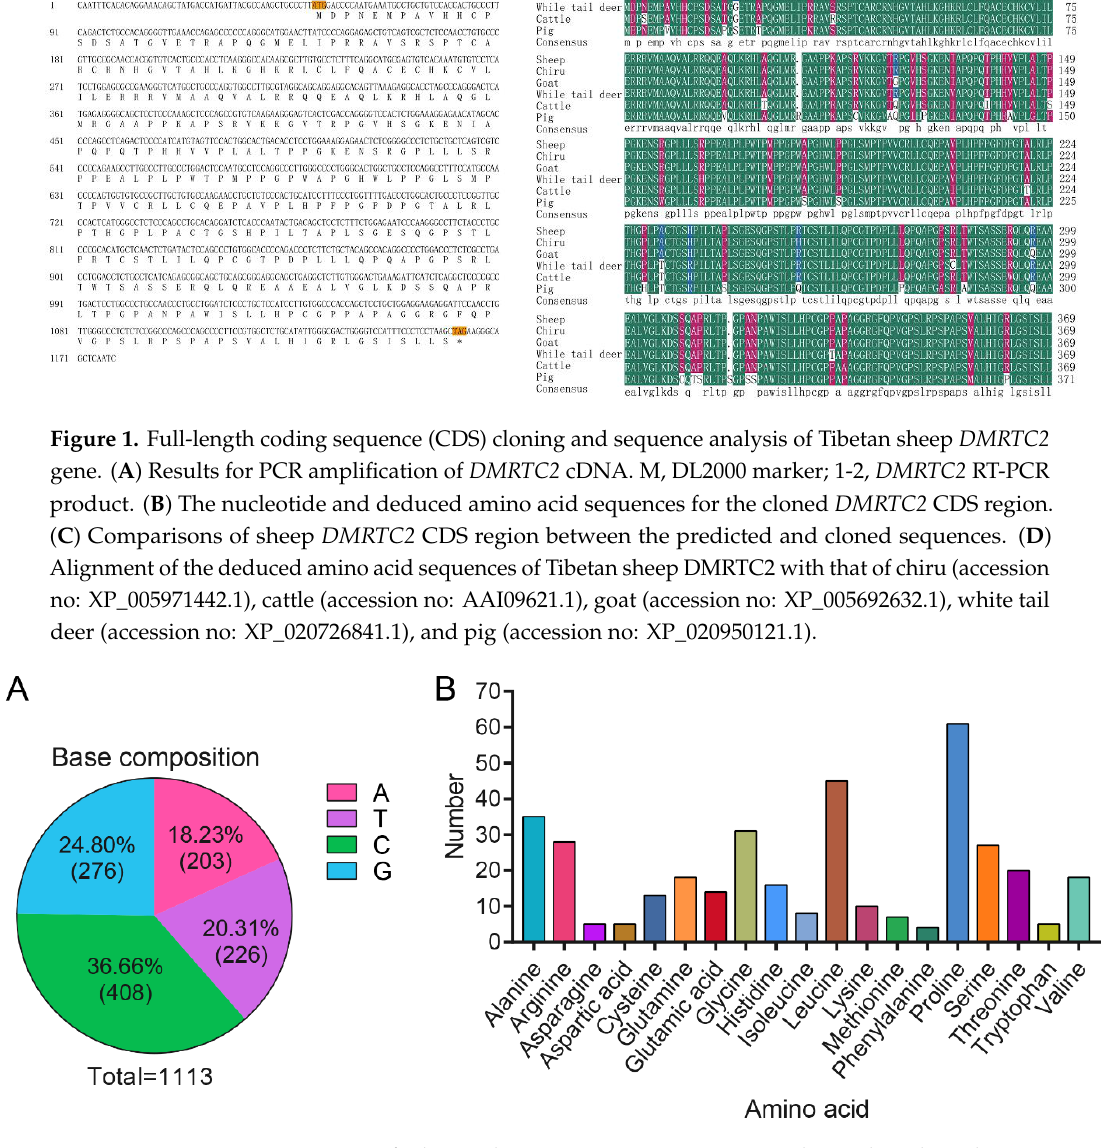
Figure 2. Sequence composition of Tibetan sheep DMRTC2 CDS region at the nucleotide and amino acid levels. ( A ) Base composition. ( B ) Amino acid composition.